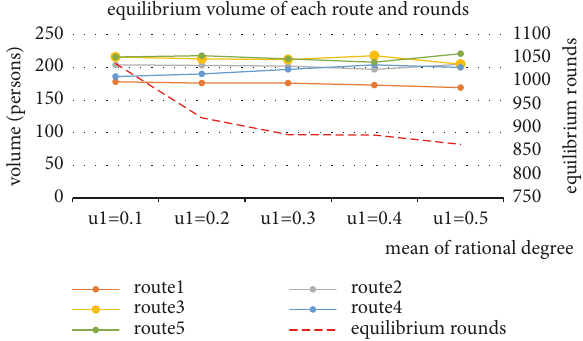
Figure 6: Volume evolution of five routes for 𝑞 = 1000 , 𝛼 = 0.3 , 𝜃 = 0.2 , Δ ∼ 𝑁(𝑢 , 0.05) 𝑖 𝑖 1